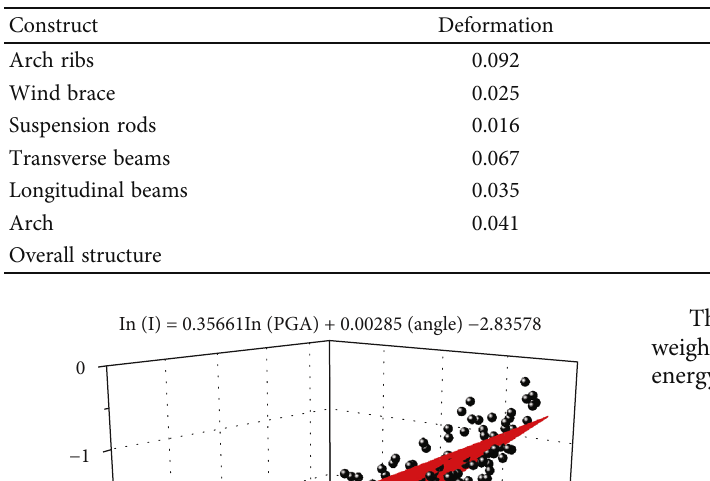
Table 6: Damage index of bridge components under non-near-fault ground motion.